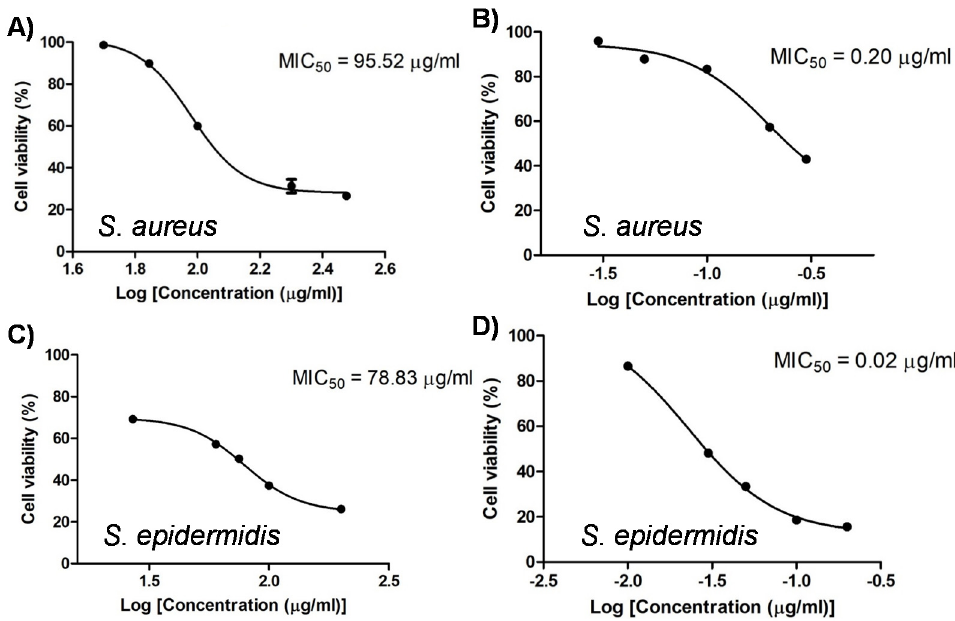
Figure 3. Antibacterial effects of the Syzygium formosum leaf extract ( A , C ). Important skin bacteria Staphylococcus aureus and S. epidermidis were used. The commercial antibacterial drug, mupirocin was used as a positive control ( B , D ). Minimal inhibition concentration 50 (MIC 50 ) was estimated and given in each graph.